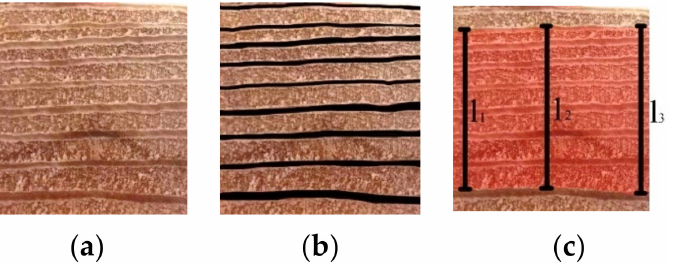
Figure 1. Three stages in the process used to record growth ring characteristics: ( a ) initial sample end face photograph; ( b ) manual extraction of latewood area; ( c ) three measurements of overall width of radial growth rings.